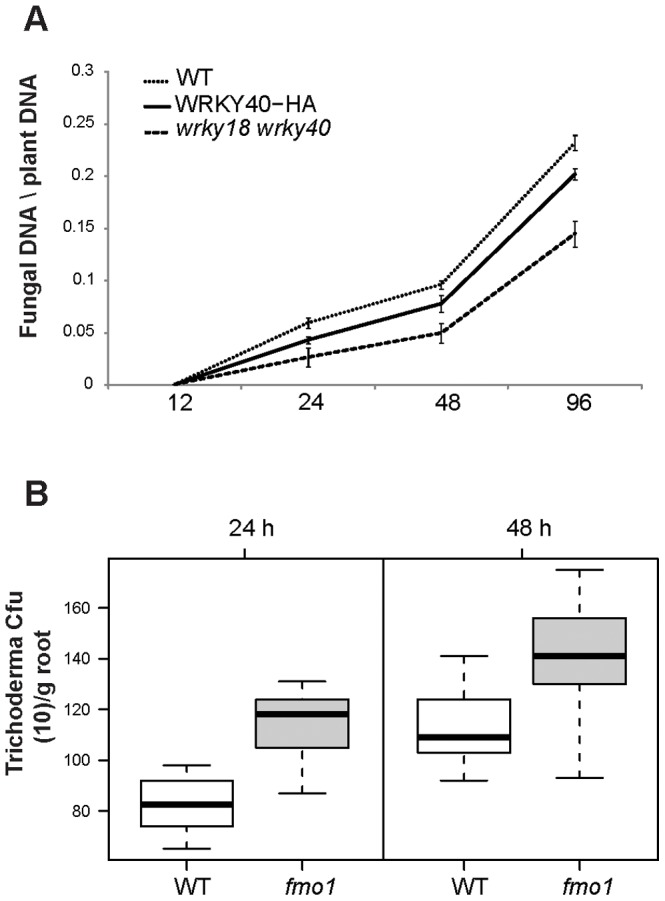
Root colonization of different Arabidopsis genotypes by T. asperelloides.Root colonization rate was quantified at different points as described in Materials and Methods section by qPCR (A) or fungal colonies count (CFU; B). The genotypes, WT (Col-0), wrky18/wrky40, WRKY40-HA complemented wrky18/wrky40 and fmo1 lines were assayed. Eight replicates were tested in each experiment, with 3 plants per treatments and the results are the average of three independent experiments. hpi: hours post-inoculation. *: = in each of the time points each of the line is significantly different from the other (P<0.001; t test).